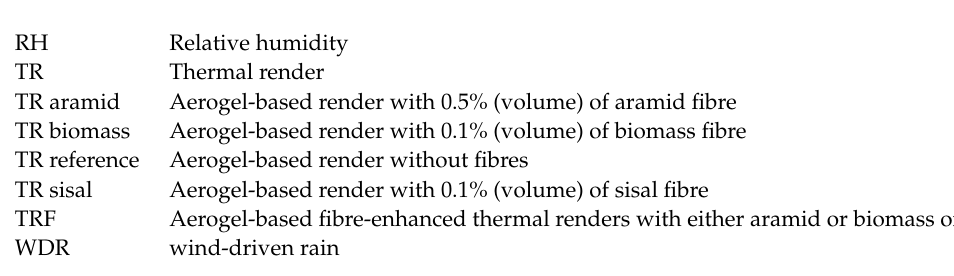
Table S2. Properties of other materials used in the simulations. Table S3. New wall solutions for Lisbon (NW). Table S4. New wall solutions for Zurich (ZNW). Table S5. Retrofit solutions are applied on the wall’s external surface (RE). Table S6. Retrofit solutions are applied on the wall’s internal surface (RI). Figure S1. Flowchart of the conducted hygrothermal simulations. Figure S2. Total water content and drying rates for Lisbon (NW) and Zurich (ZNW). Figure S3. Isopleth example for the ZNW1 solution. Figure S4. Ratio of water content to w f for the renders. Figure S5. Temperatures were verified for the different solutions. Figure S6. Superficial condensation potential. Figure S7. Thermal insulation losses over the reference performance during the year. Figure S8. Heat loss during the winter per square metre of wall. Figure S9. Total water content and drying rates of the solutions (RE scenario). Figure S10. Mould growth potential. Figure S11. Ratio of water content to w f for the renders. Figure S12. Temperatures were verified in the simulation. Figure S13. Conditions for the formation of superficial condensation. Figure S14. Thermal insulation loss over the year. Figure S15. Heat loss during the winter, per square metre of wall. Figure S16. Total water content and drying potential rate. Figure S17. Ratio of water content to w f for the renders. Figure S18. Temperatures were verified in the simulation. Figure S19. Verification of the conditions for the formation of superficial condensation. Figure S20. Thermal insulation loss over the year. Figure S21. Heat loss during the winter, per square metre of